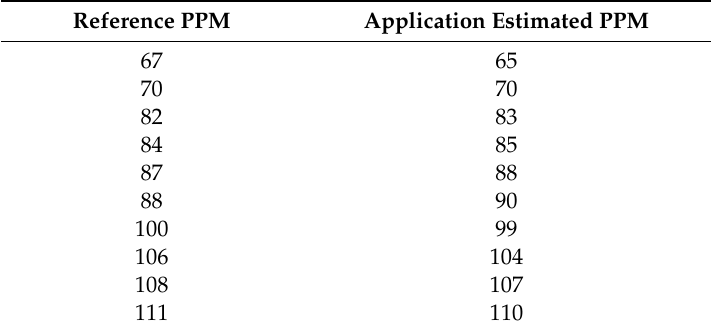
Table 1. Pulses per minute (PPM) values obtained (less 20%) in di ff erent subjects during the validation process.